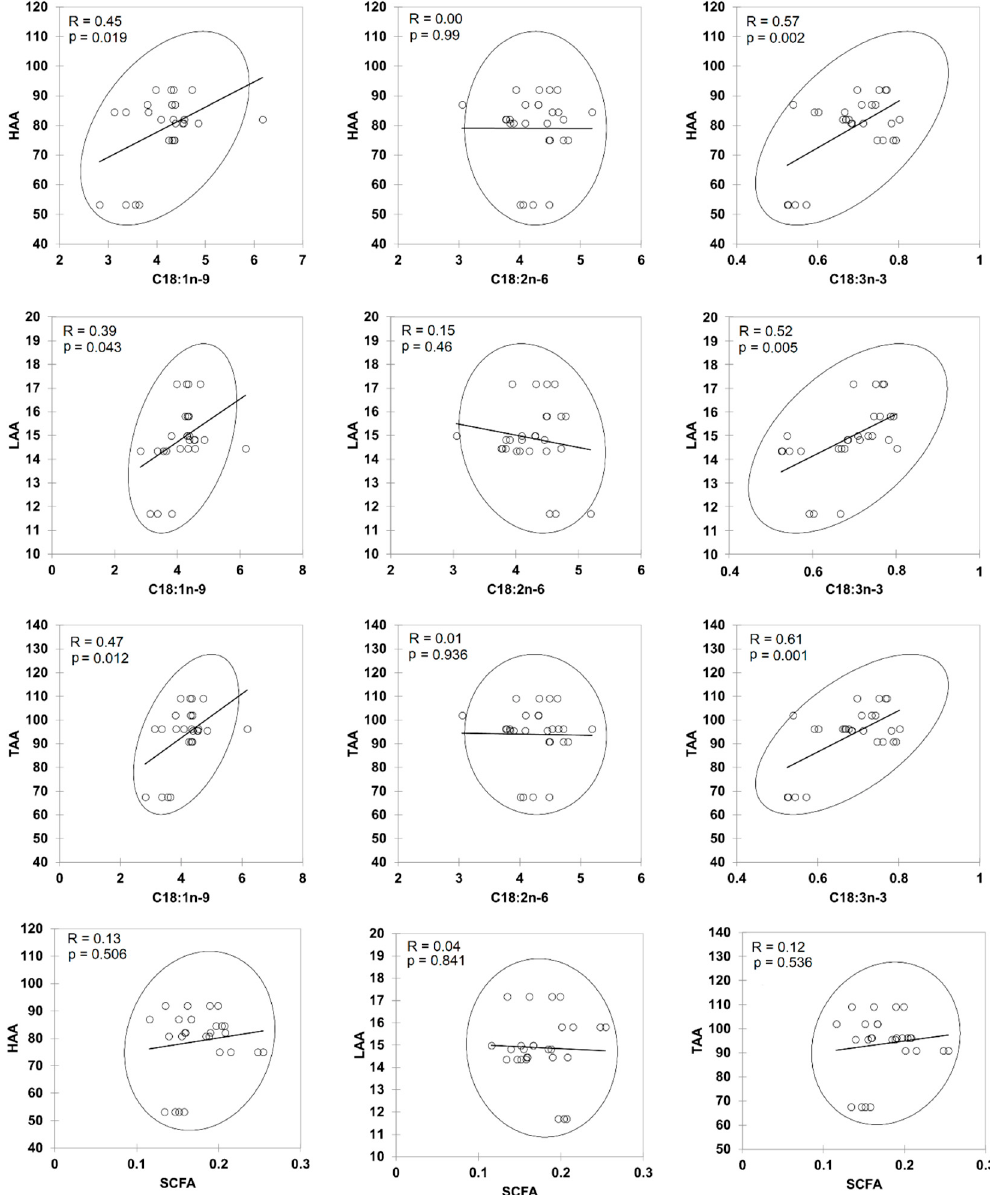
Figure 7. Scatter plots showing relationships between the antioxidants activities and unsaponified fatty acids in different commercial natural soaps after cold saponification. HAA = hydrophilic antioxidant activity, LAA = lipophilic antioxidant activity, TAA = total antioxidant activity. Short Chain Fatty Acids (SCFA) =